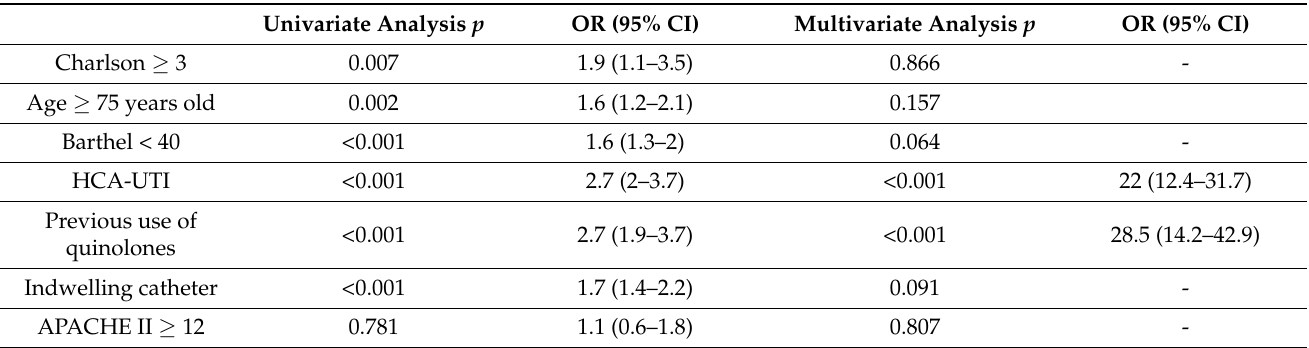
Table 3. Multivariate analysis of risk factors for resistance to ciprofloxacin of complicated community- acquired urinary tract